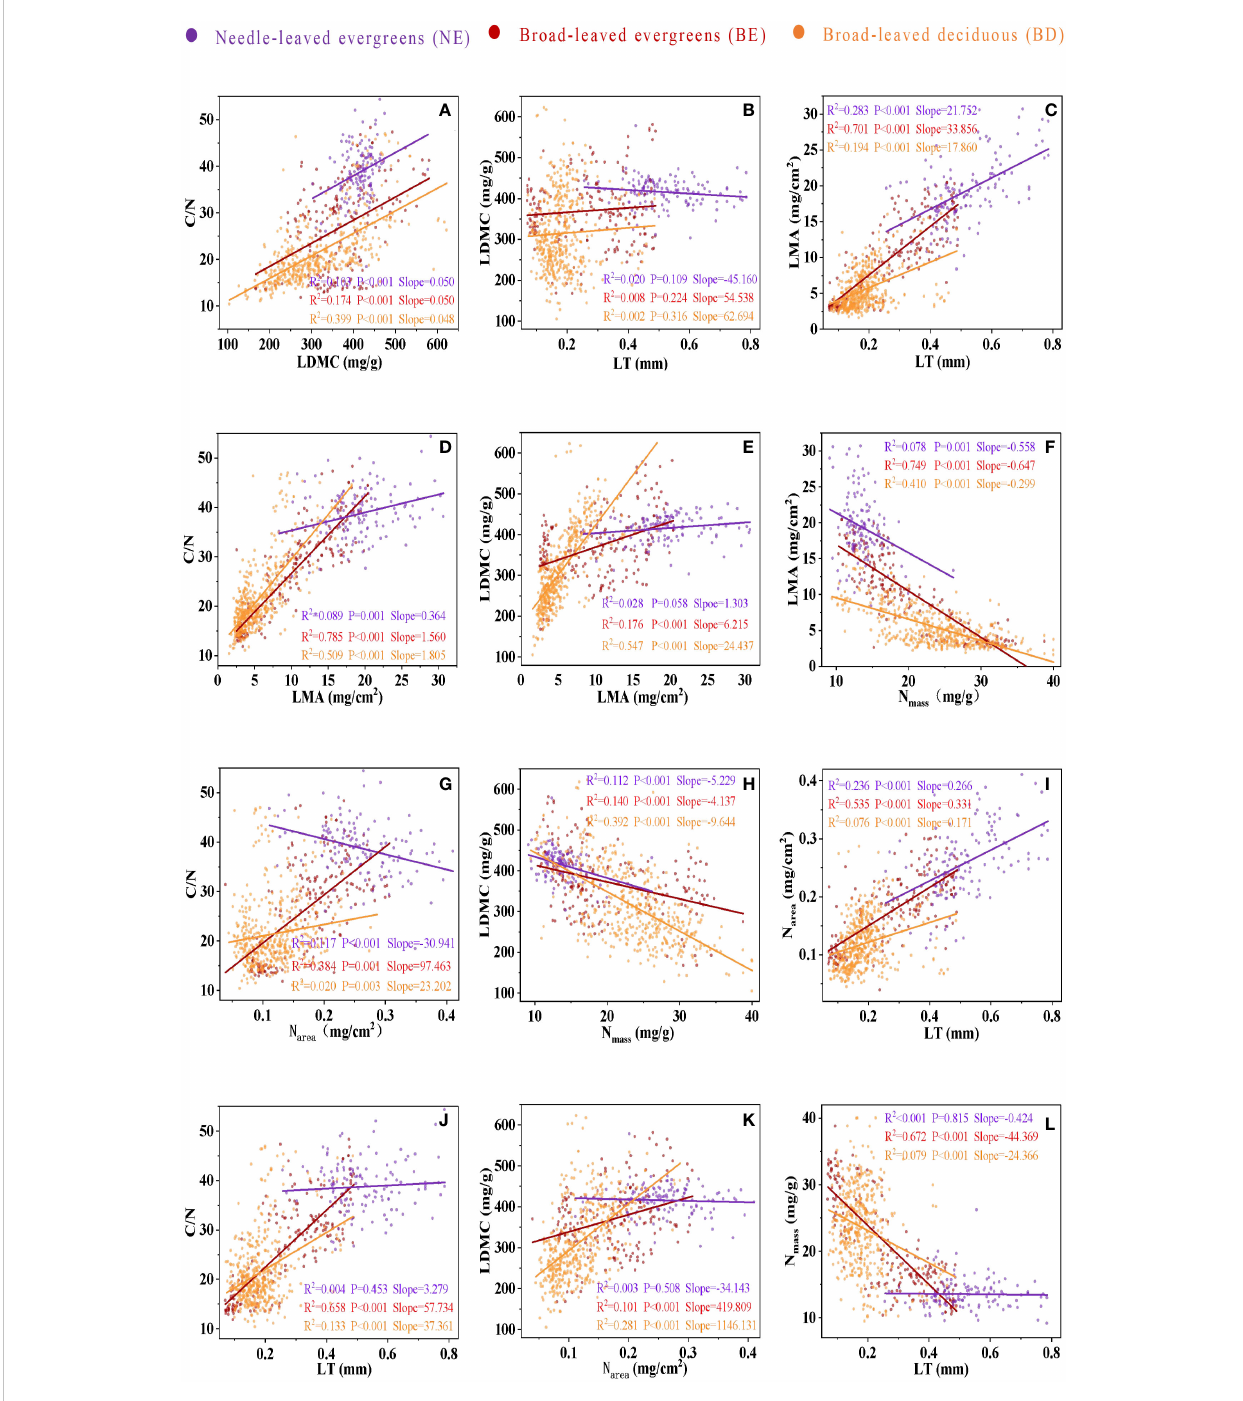
FIGURE 3 The bivariate relationship between C/N and LDMC (A) , between LDMC and LT (B) , between LMA and LT (C) , between C/N and LMA (D) , between LDMC and LMA (E) , between LMA and Nmass (F) , between C/N and Narea (G) , between LDMC and Nmass (H) , between Narea and LT (I) , between C/N and LT (J) , between LDMC and Narea (K) , and between Nmass and LT (L) . Needle-leaved evergreens (NE), broad-leaved evergreens (BE), and broad-leaved deciduous (BD) are shown in purple, red, and orange respectively. Solid lines represent the fi tting curves, R2 represents the fi tting degree of the solid line, P represents the signi fi cance level, and slope represents the slope of the solid